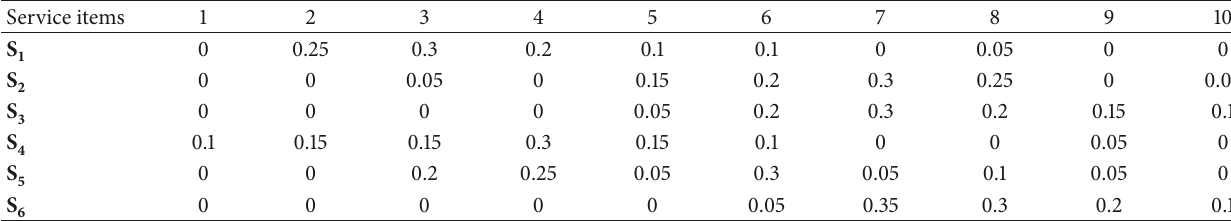
Table 6: Expected probability distribution of service items.